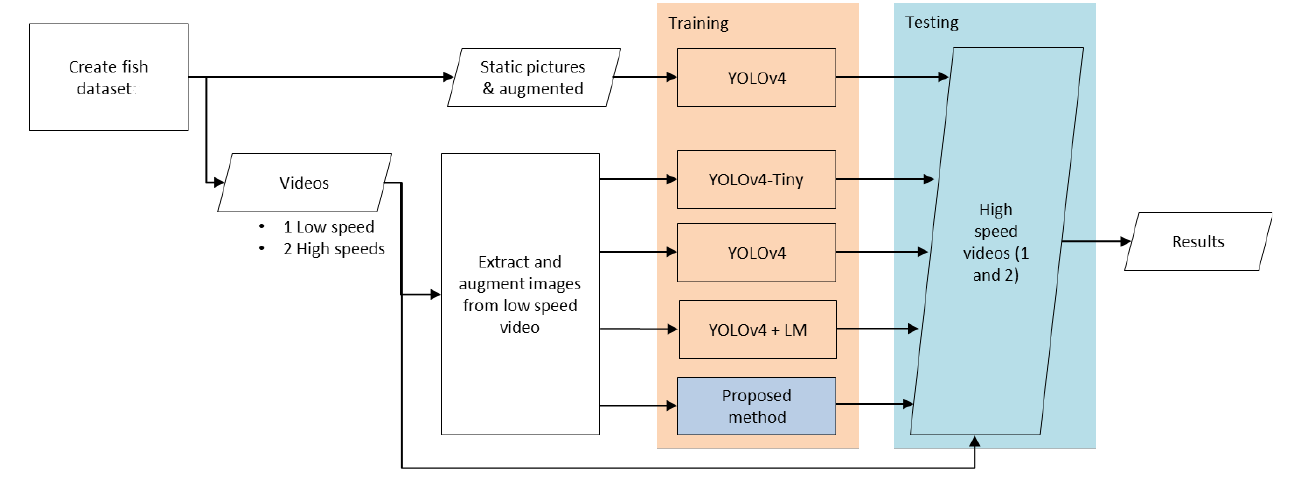
Figure 6. The work flowchart.